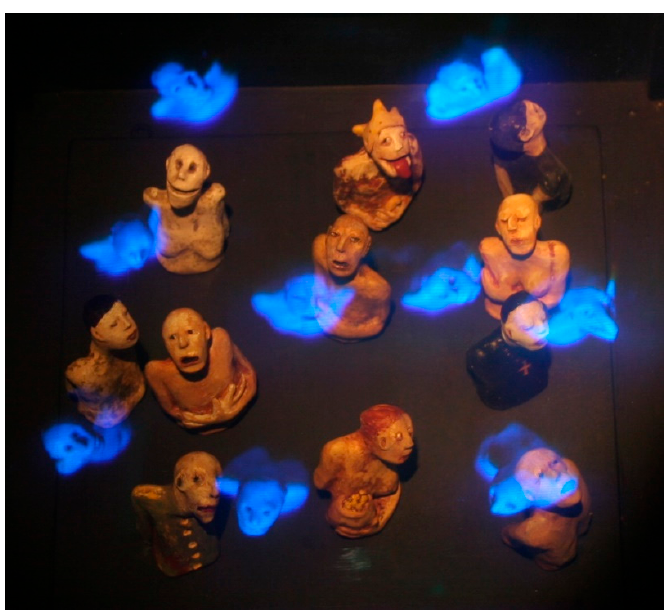
Figure 8. Anthropos (2017–18), reflection hologram, metal box, 25 cm × 25 cm × 10 cm, clay figures 6 cm.